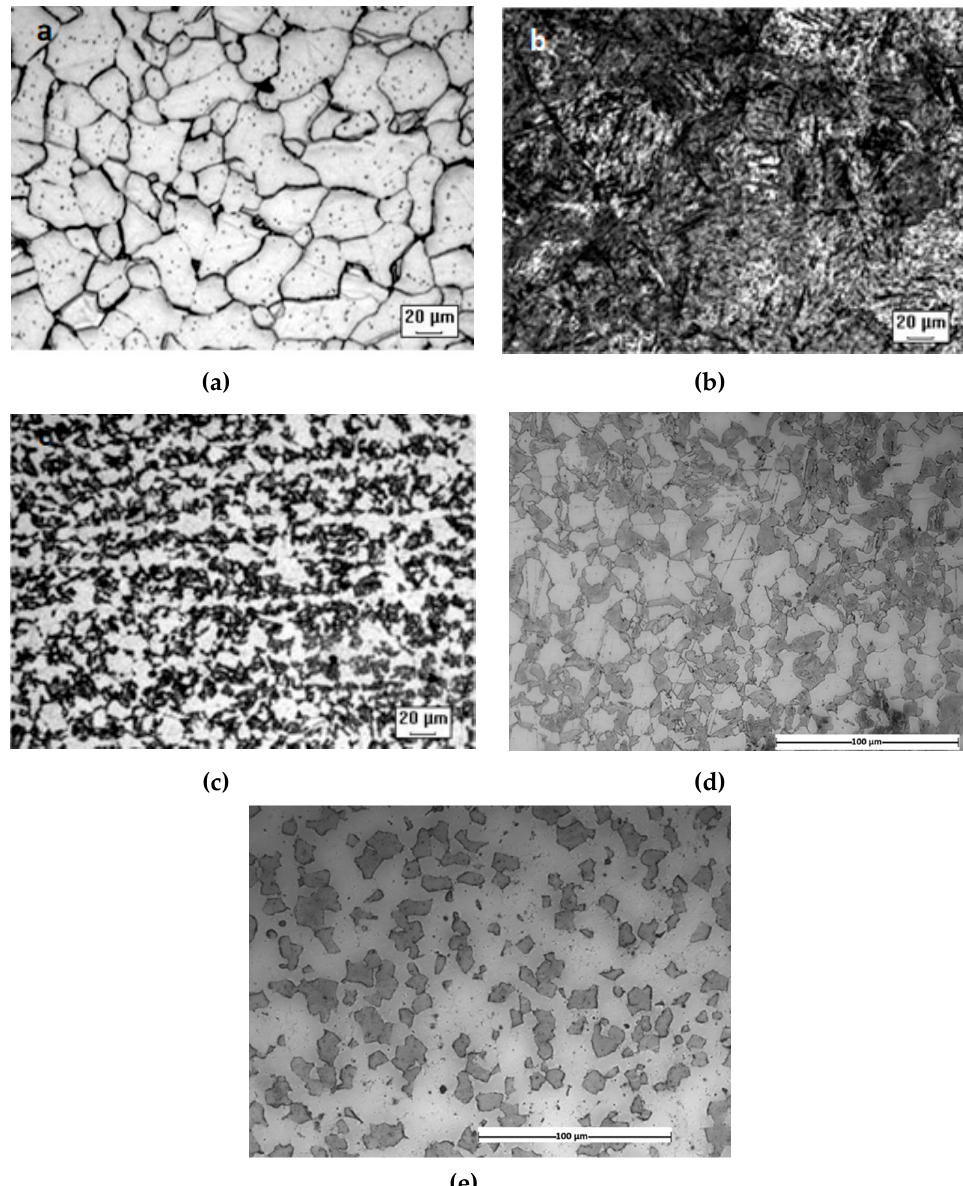
Figure 2. Optical metallography of ( a ) ULC, ( b ) MC and ( c ) DP0 steels. Etched with Nital 2%. ( d ) DP1 and ( e ) DP2.